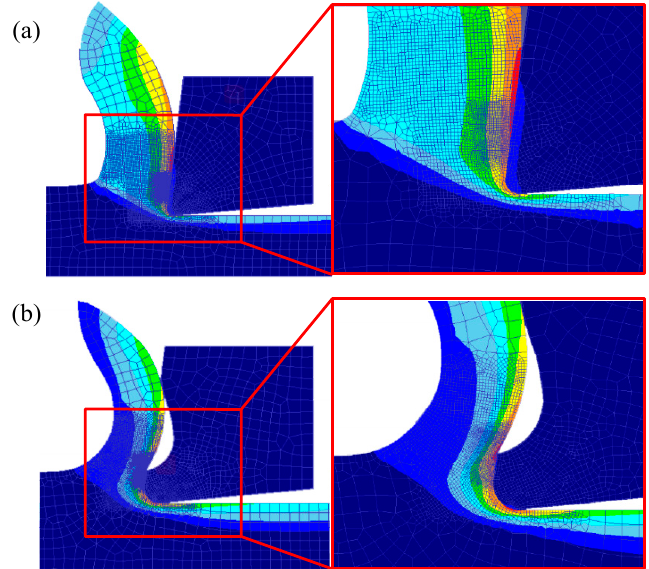
Figure 2. ( a ) Cutting simulation of Tool A. ( b ) Cutting simulation of Tool B. Tools A and B were manufactured by the powder metallurgy. The main component was WC, and the surfaces of Tools A and B in the thickness of 3 µ m were coated with TiAlN. The micro-groove shape and size of Tool B is shown in Figure 3.